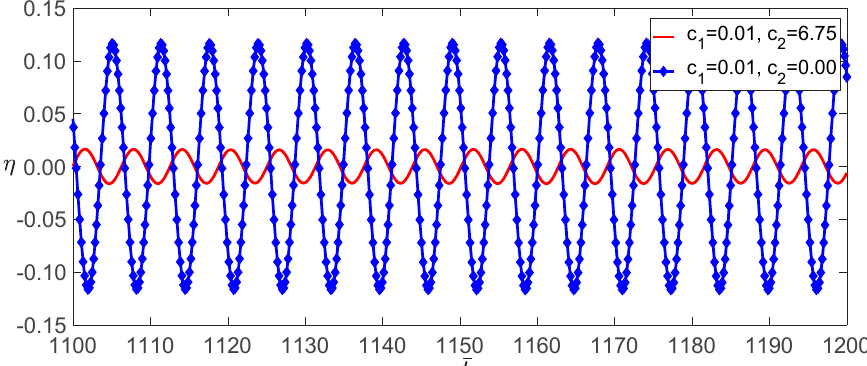
with σ = − 10 for several damping parameters.